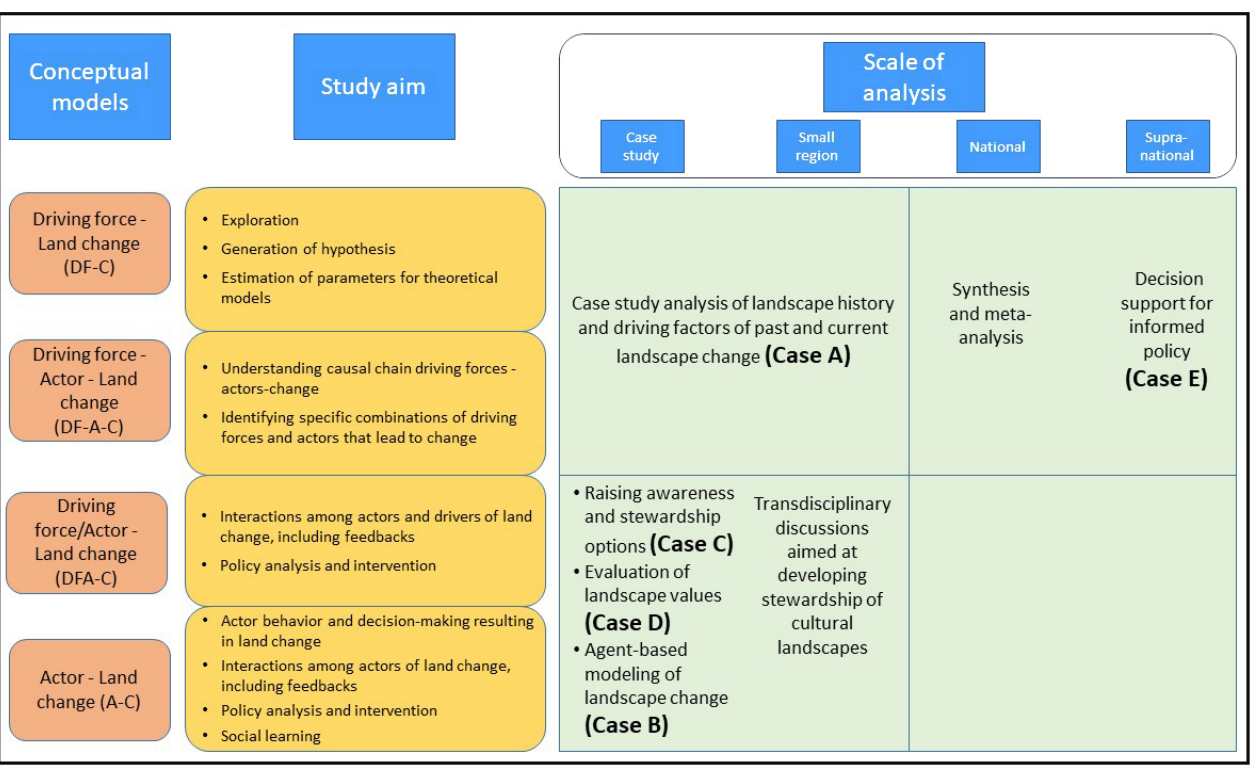
Fig. 2 .The four conceptual models of Hesperger et al. (2010), with scale of analysis and research approaches for the case studies of the Gera